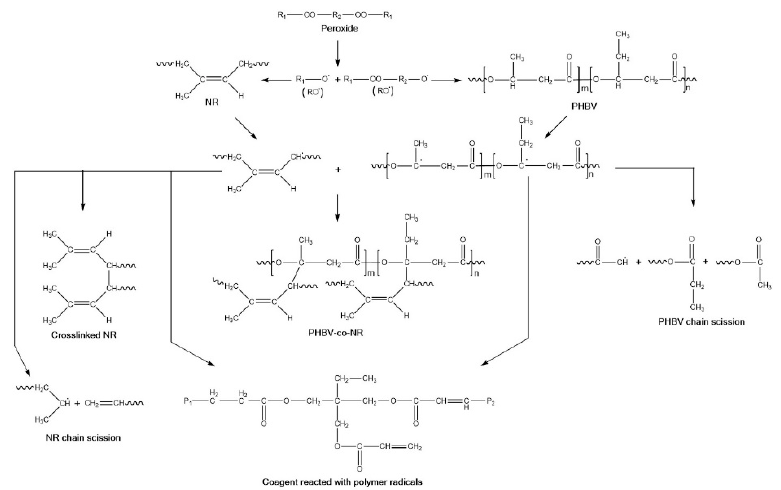
Figure 8. Possible reactions during melt blending of PHBV and NR in the presence of peroxide and coagent.